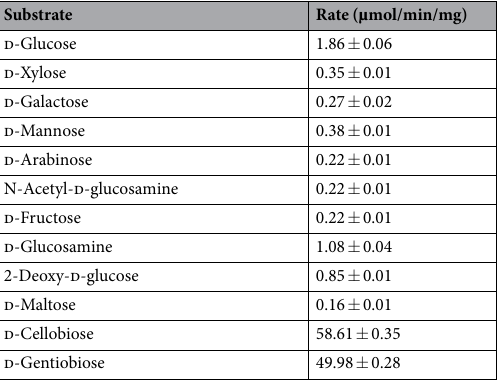
Table 1. Substrate specificities of TaCBP in the synthetic reaction. Concentration of each substrate used was 10